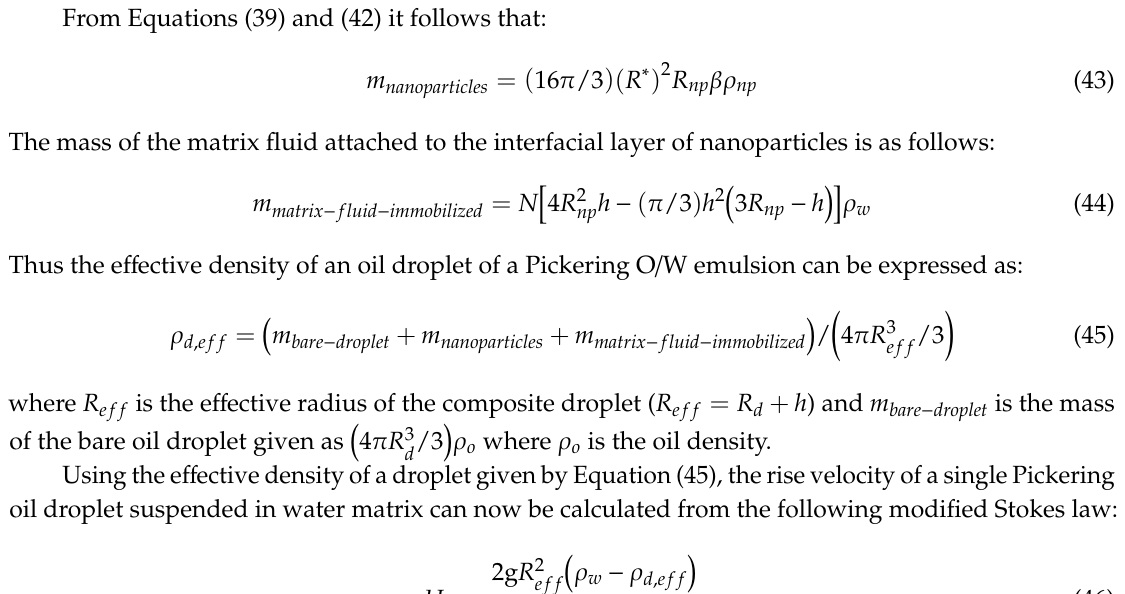
Figure 13. Thickness of interfacial layer of solid nanoparticles protruding into the continuous phase of an emulsion.